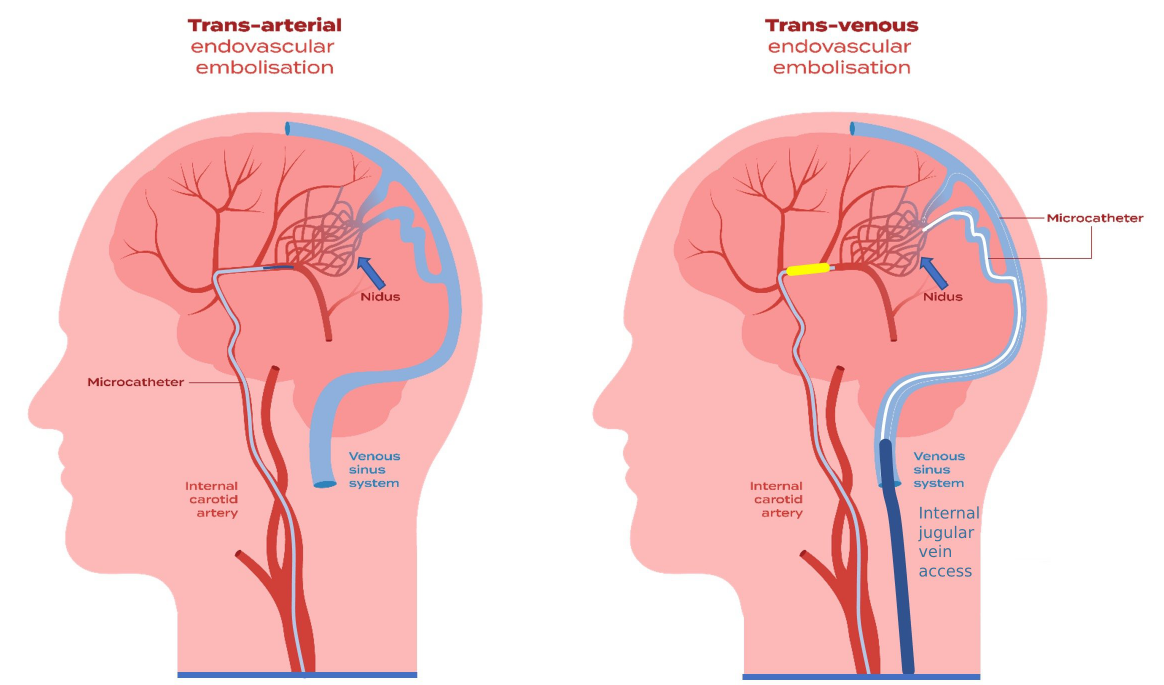
Figure 2. Endovascular embolization can be conducted with the use of two approaches—the transarte- rial approach (TAE) and the transvenous approach (TVE). A TAE can be used to support a TVE during the same or one previous preparatory session, or a TAE can be employed to rescue an incomplete TVE. In some cases, balloon catheterization can be used transarterially to assist a